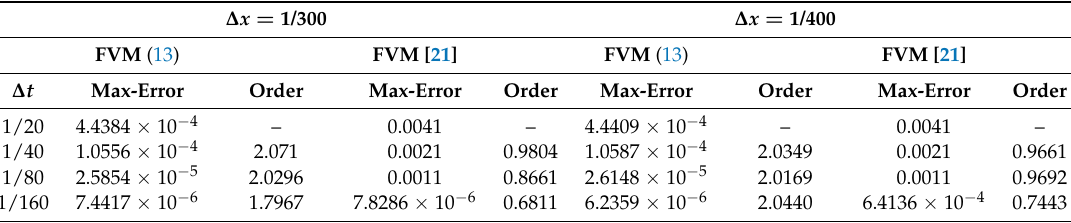
Table 6. Temporal convergence order of new upwind FVM and existing upwind approach of FVM taking k = 0.7, v = 0.05 in case of convection dominance.